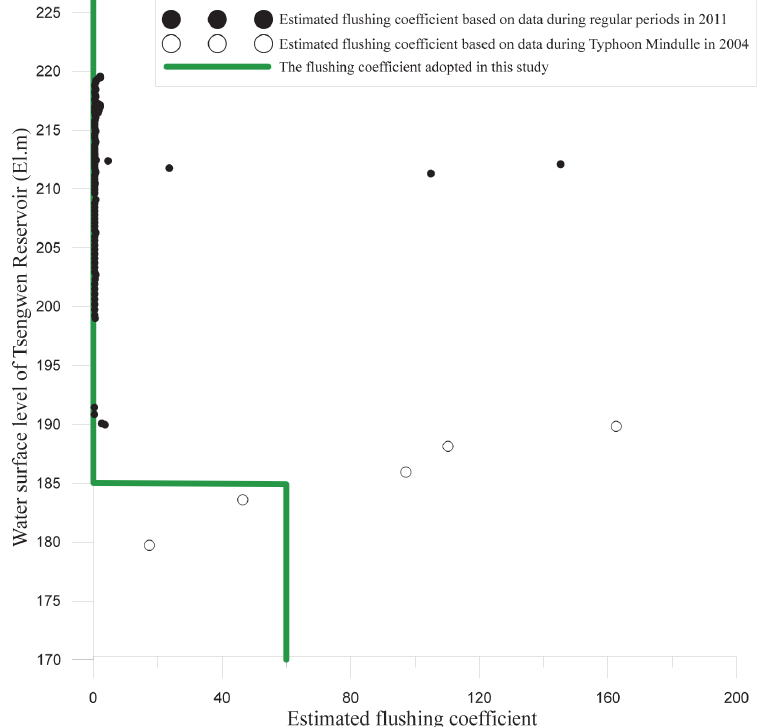
Figure A1. Relationship between the flushing coefficient and WSL of Tsengwen Reservoir.